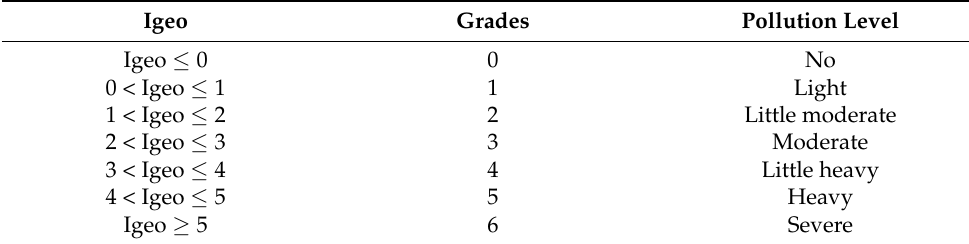
Table 1. Criteria for geo-accumulation index.